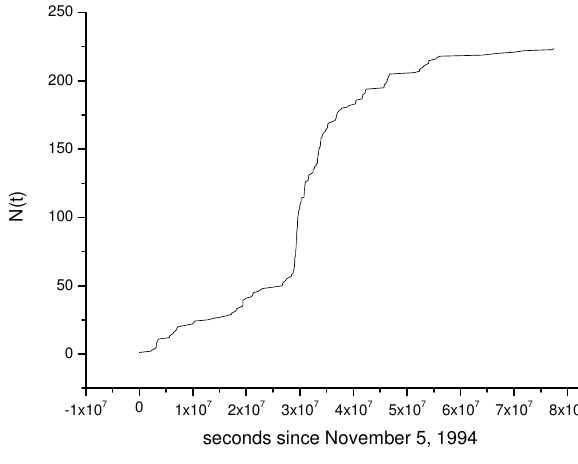
Fig. 2. Time distribution of the earthquakes of cluster a. The num- ber of events is 224.